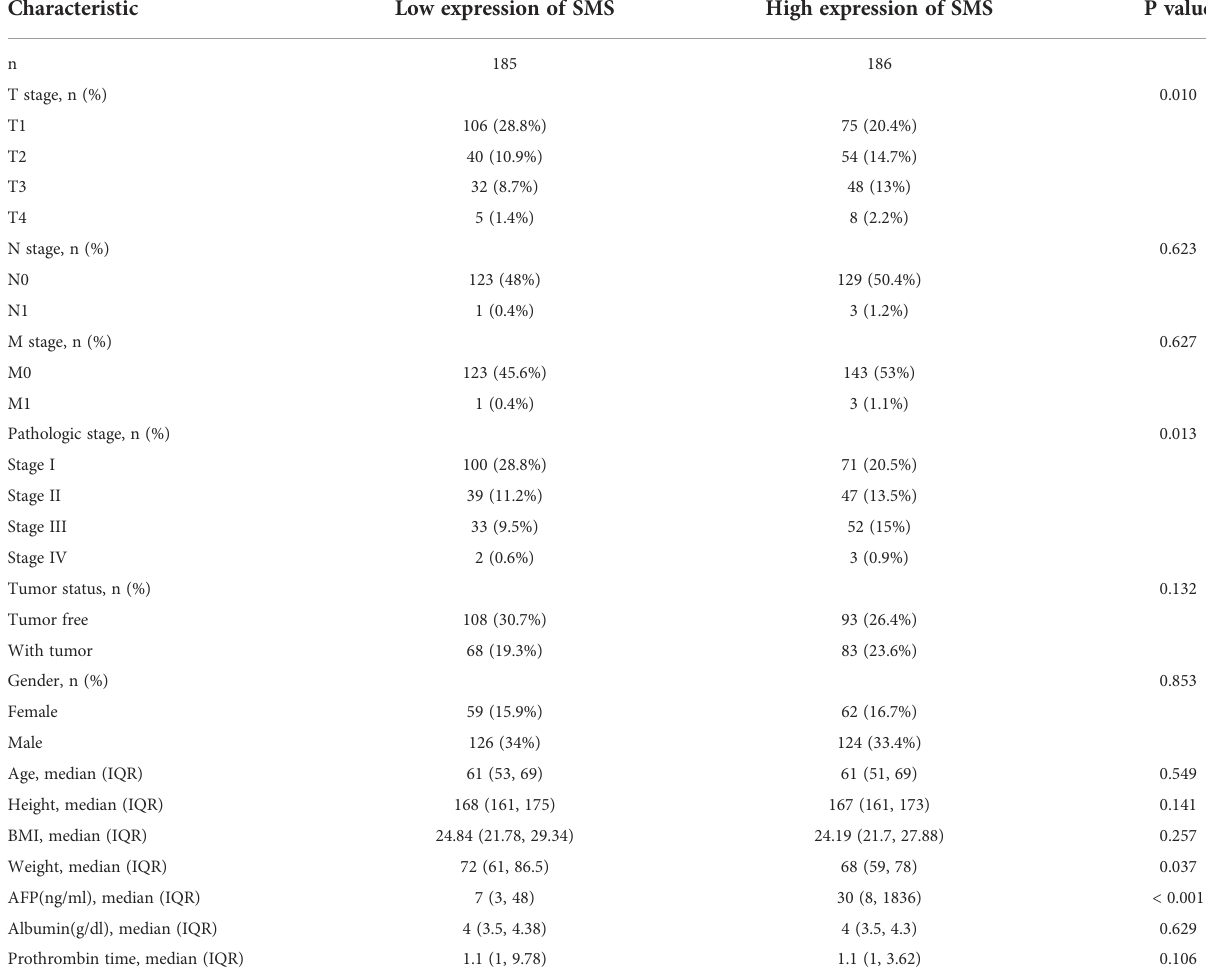
TABLE 1 Clinical characteristics of HCC patients in TCGA database.